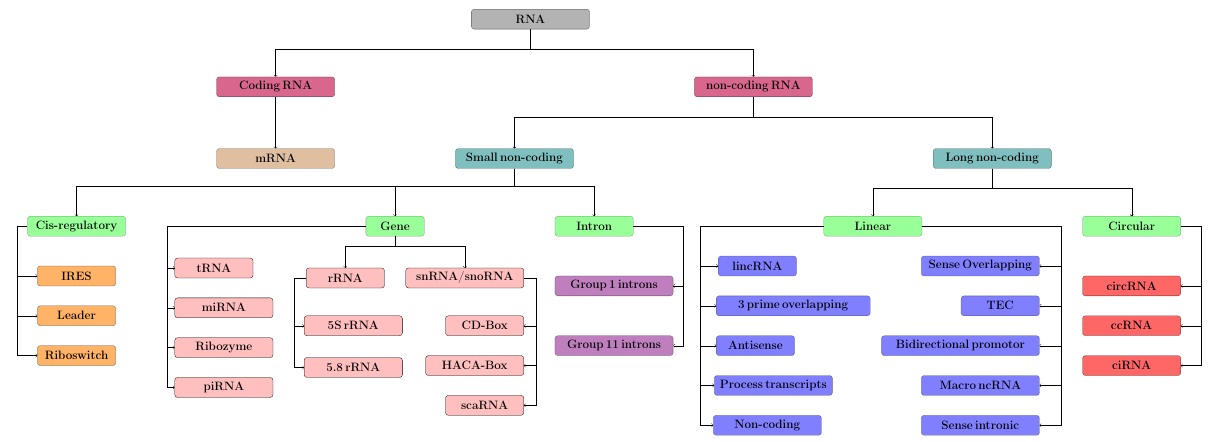
Figure 1. Hierarchical representation of RNA